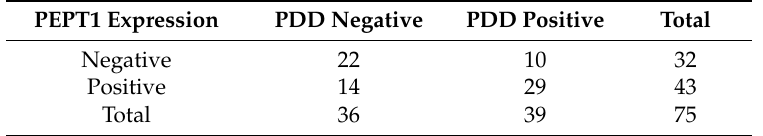
Table 1. Correlation between PEPT1 immunoreactivity and PDD in PM ( p = 0.0019) [20].